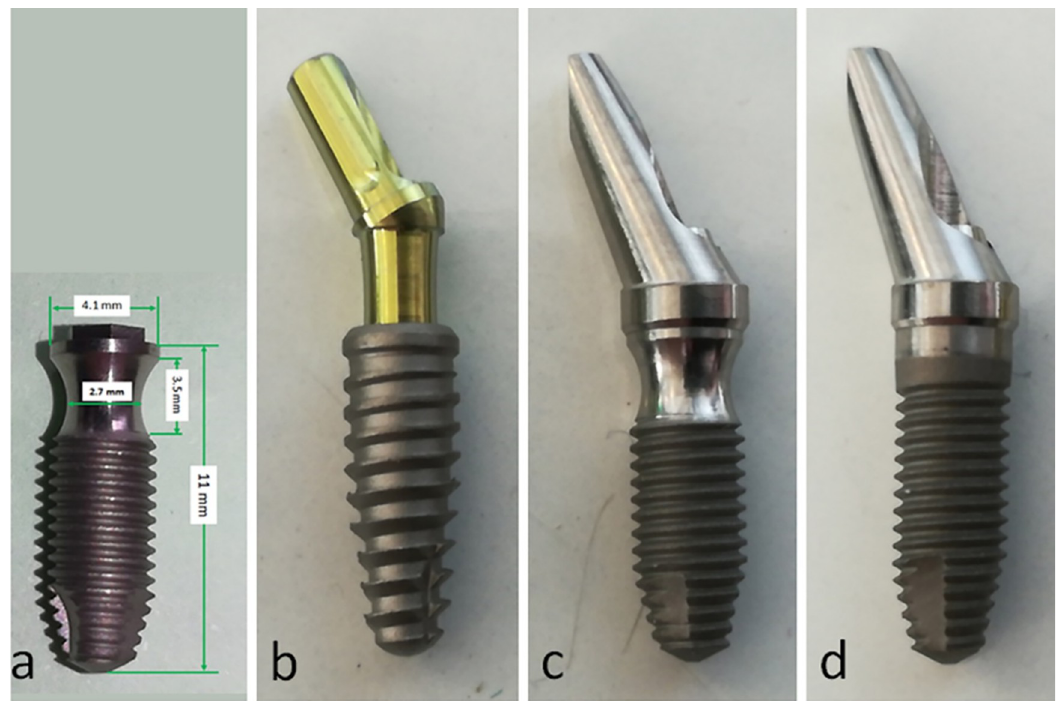
Fig 2. (a) Details of new Collo implant characteristics and dimensions; (b) sample implant and abutment used in the MT group; (c) sample implant and abutment used in the Collo out and Collo bl groups; and (d) sample implant and abutment used for the EH con